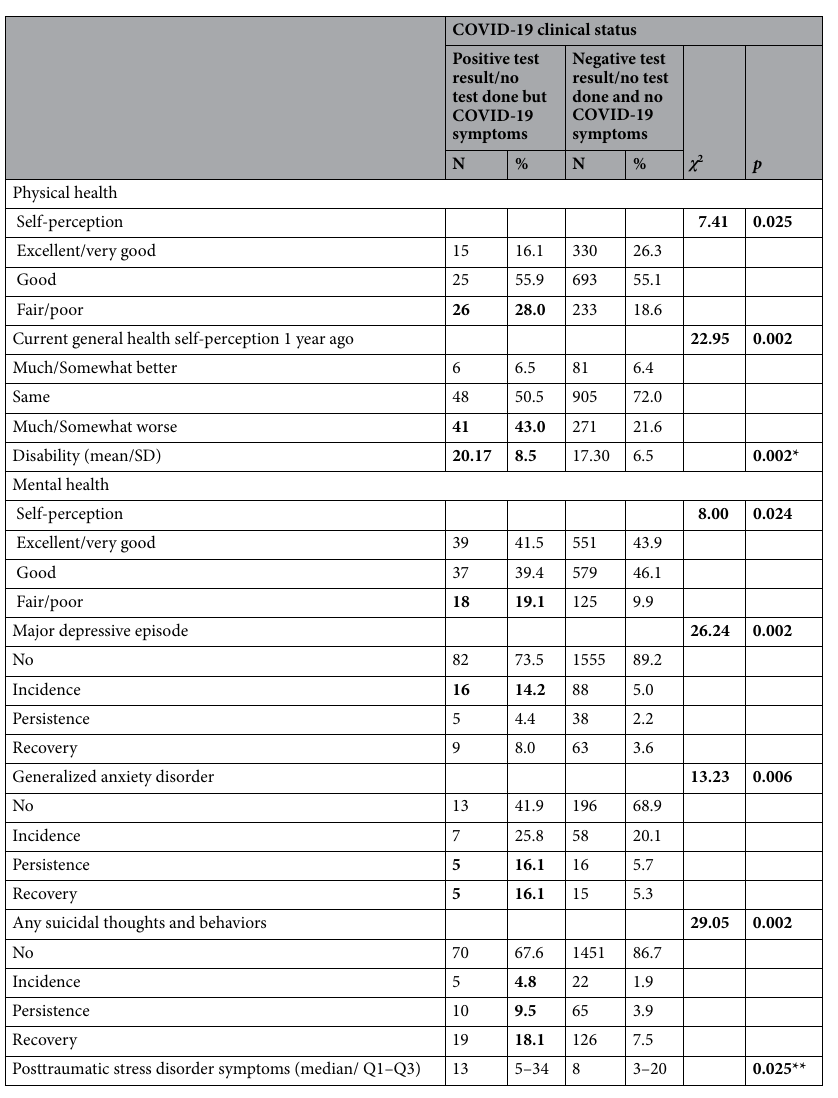
Table 3. Association between COVID-19 clinical status (positive or those with no test done but COVID- 19-related symptoms vs. Negative test result or No test done and no COVID-19 symptoms) and physical and mental health. Q 1 , First quartile ; Q 3 , Third quartile. % weighted follow-up sample weight (inverse probability weighting and post-stratification). *Student’s t-test for independent samples; ** U-Mann non-parametric test for independent samples. Significant values are in